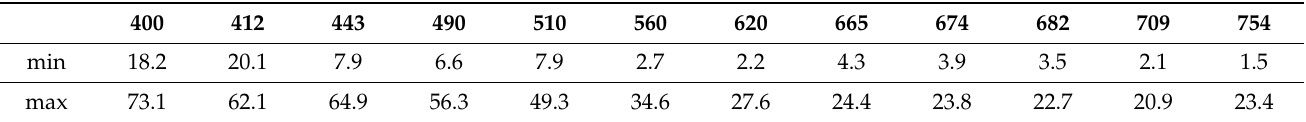
Table 6. Minimum (min) and maximum (max) relative errors of R rs recovery when using the measured AOD and P2